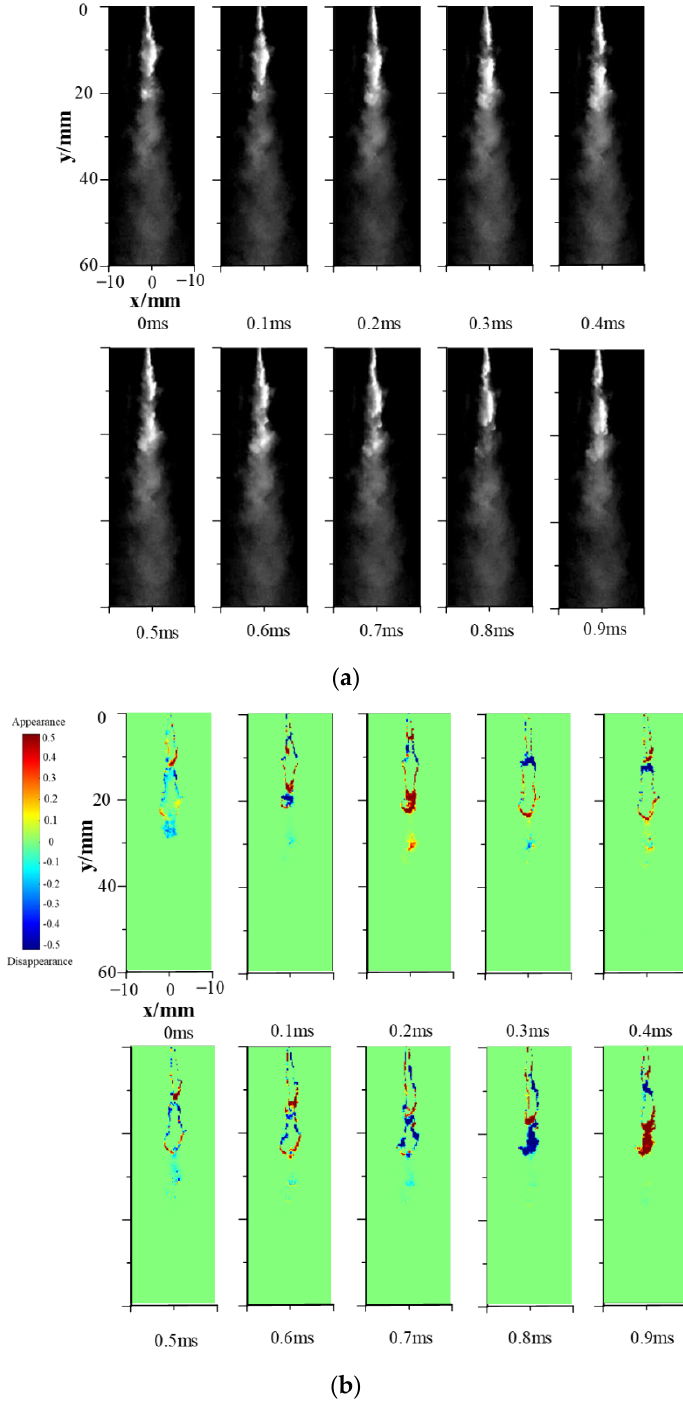
Figure 4. Dynamic change in the cavitation cloud in a single period under an inlet pressure of 20 MPa: ( a ) high-speed photography image of the cavitation cloud; ( b ) FDM diagram.